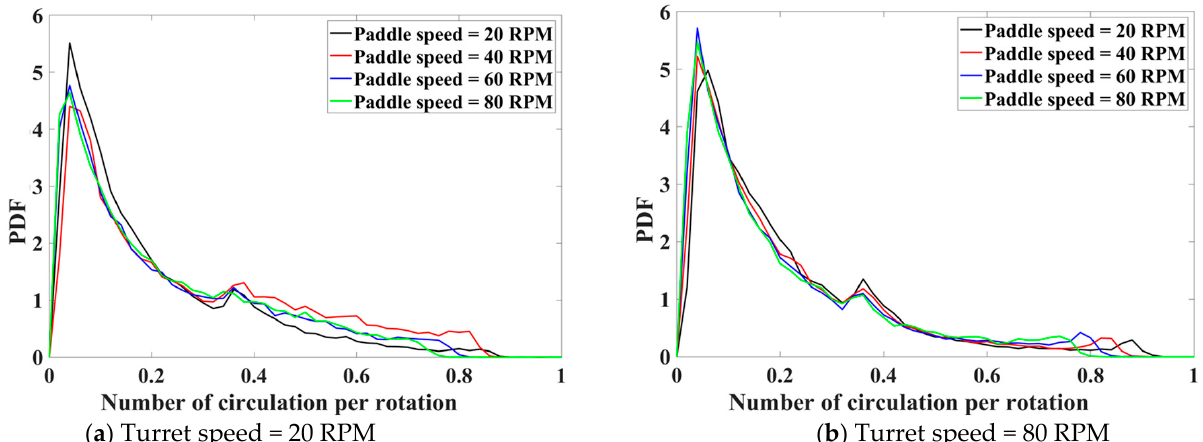
Figure 7. Effect of paddle speed on normalized distance traveled defined as number of circulation per paddle rotation at different turret speeds; ( a ) 20 RPM; ( b ) 80 RPM for four different paddle speeds 20 RPM, 40 RPM, 60 RPM, and 80 RPM.